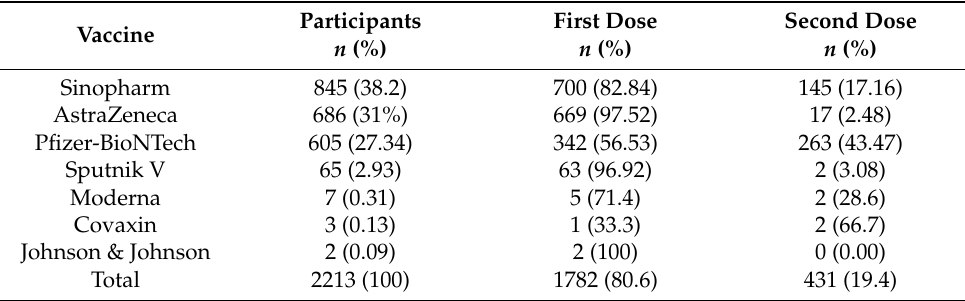
Table 3. Classification of participants based on types of COVID-19 vaccine.